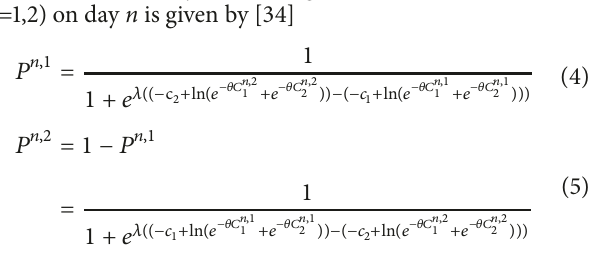
in the same direction that are connected to an origin (O) and a destination